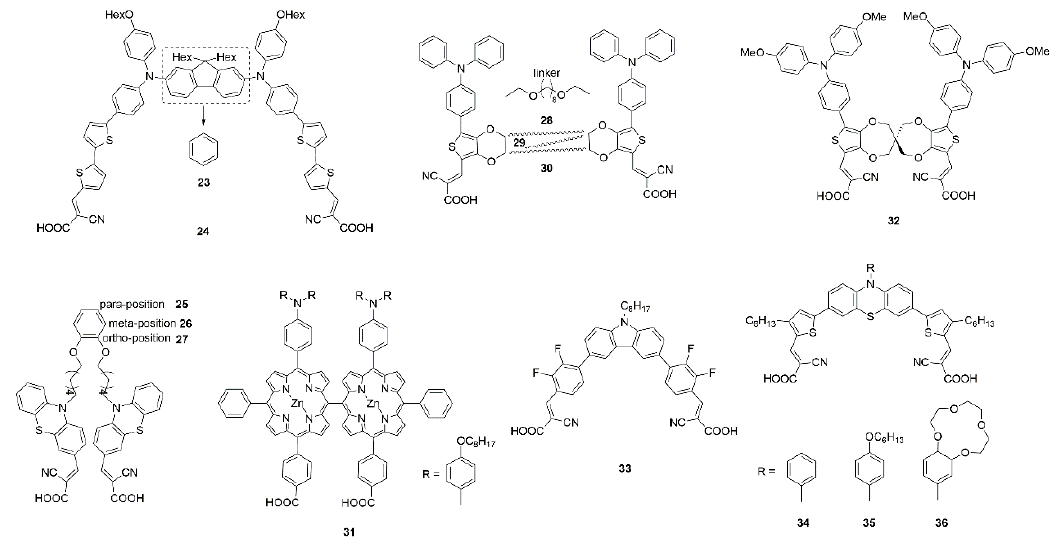
Figure 7. Chemical structures of dyes 23 – 36 .